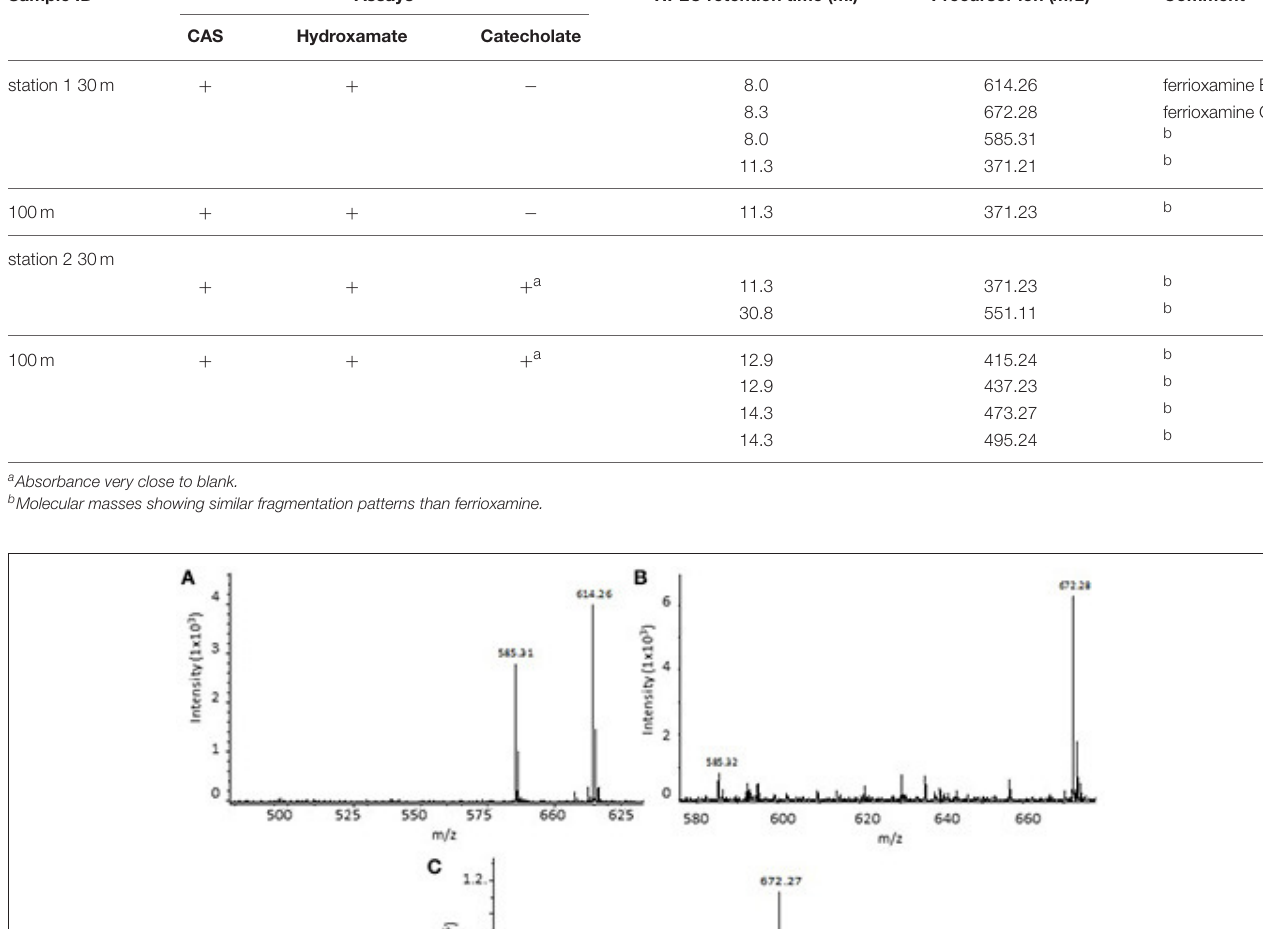
TABLE 3 | Summary of results from the characterization of siderophore type compounds extracted from incubation experiments of marine particles at the end of the treatment. Sample ID